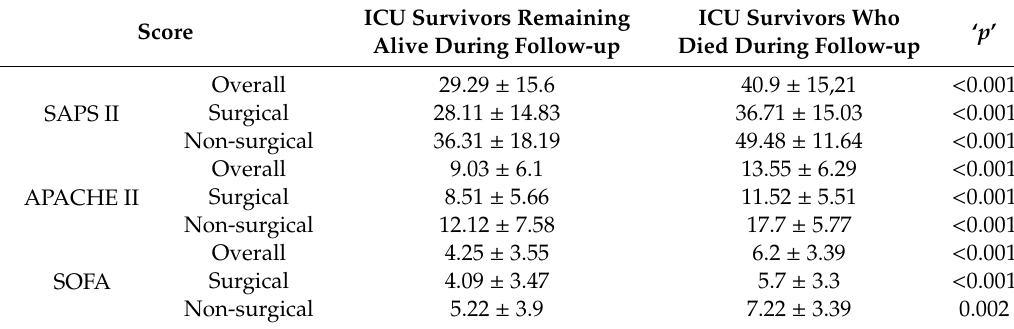
Table 4. SAPS II, APACHE II, SOFA scores and post-ICU mortality in ICU survivors.